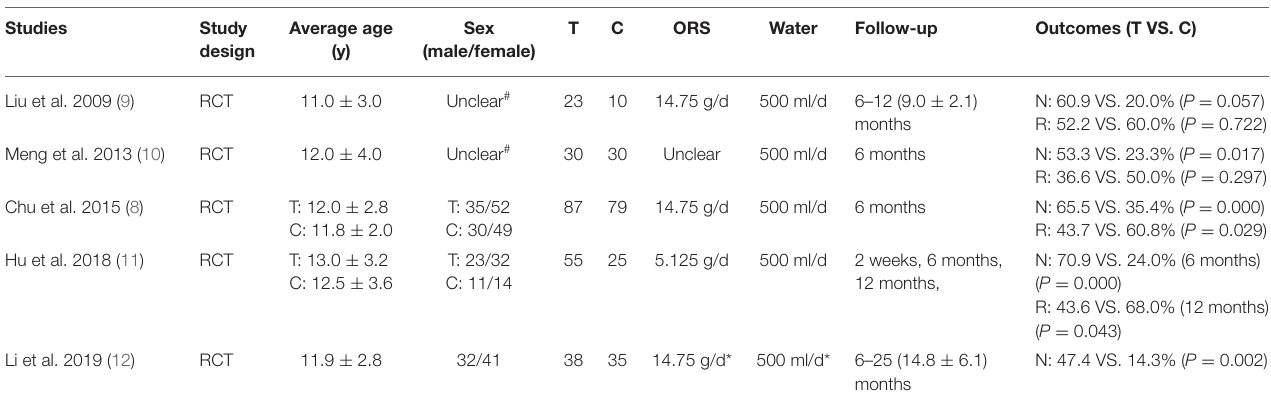
TABLE 1 | Basic information of included studies.